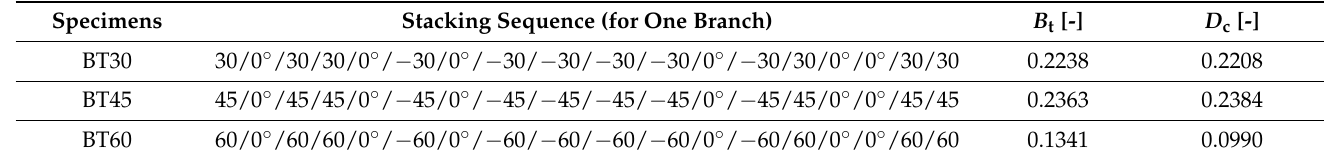
Table 2. Experimental elastically coupled laminates with different fiber orientation